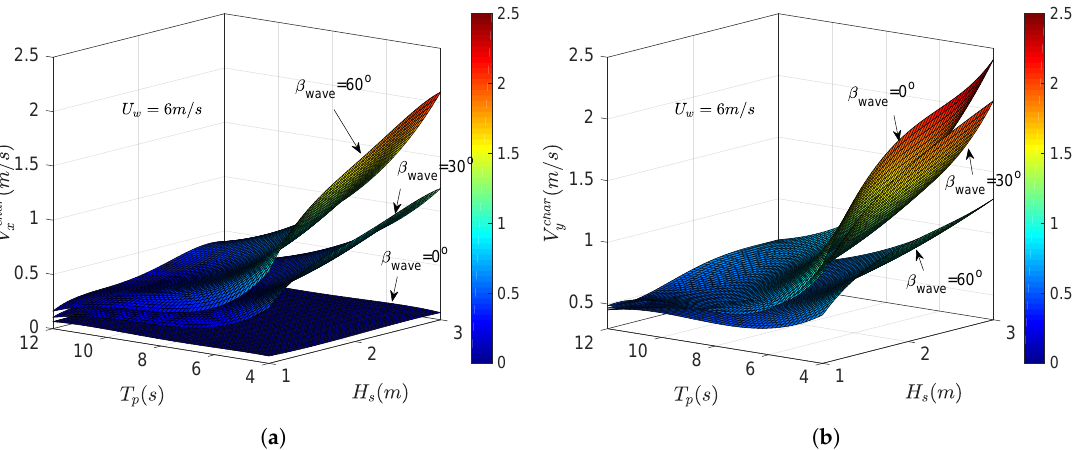
Figure 15. Response surface for ( a ) V char x and ( b ) V char y for different H s , T p , β wave = 0°, 30°, 60° and U w = 6